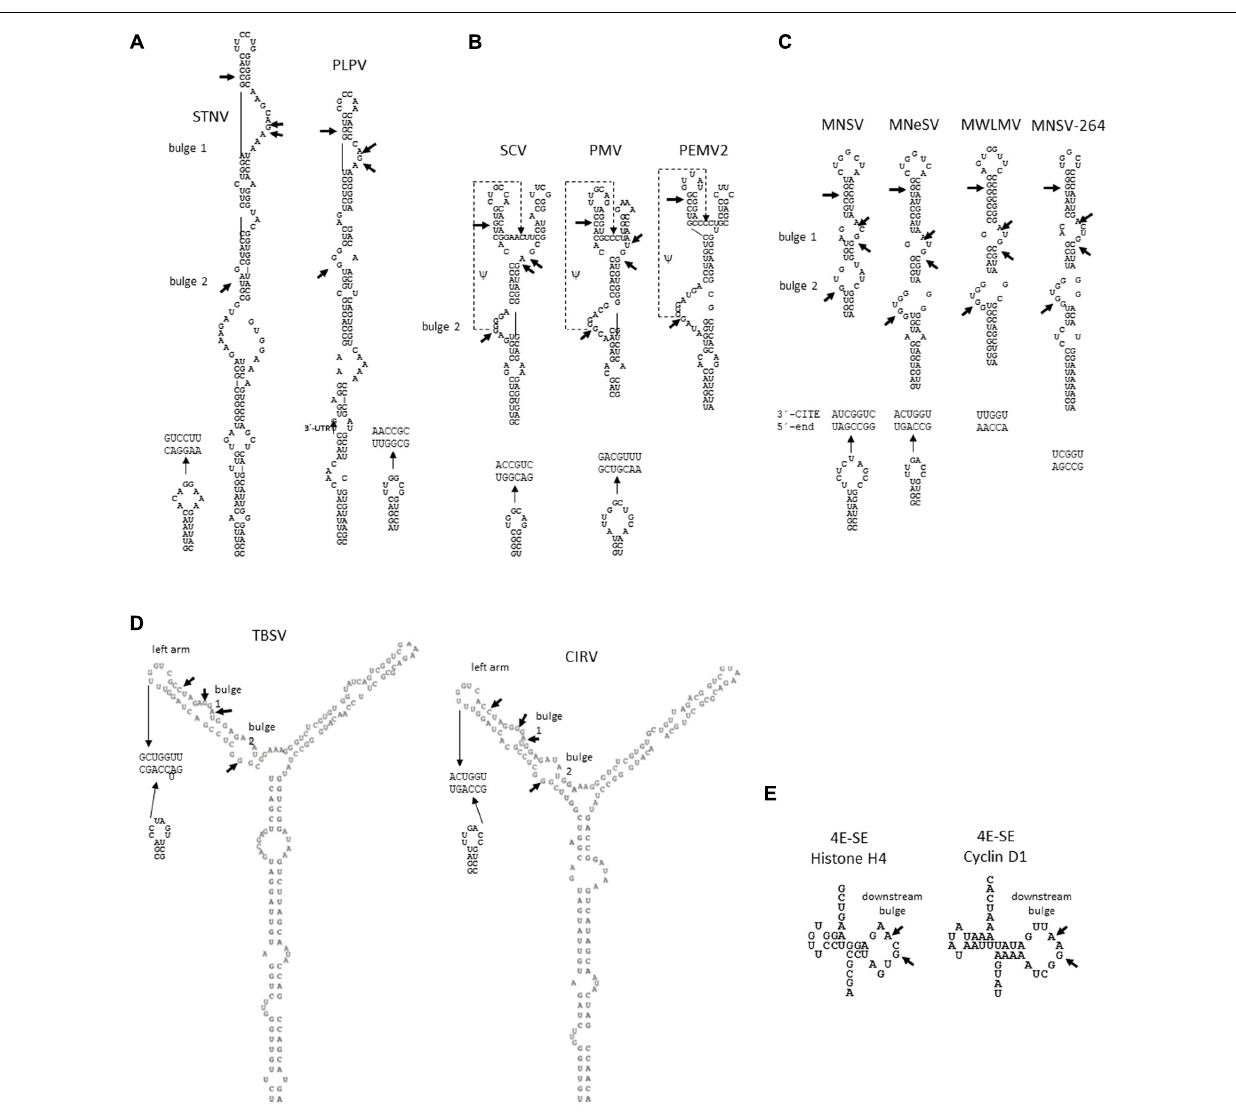
FIGURE 2 | RNA secondary structures of TED, PTE, ISS, and YSS, which are 3 (cid:48) -CITEs shown or proposed to interact with eIF4F through its eIF4E subunit. (A) Assayed (PLPV) and predicted (STNV) TED structures, based on data derived from Blanco-Pérez et al. (2016). (B) Assayed PTE structures of SCV, based on data derived from Chattopadhyay et al. (2011) and of PEMV and predicted PTE structure for PMV, based on data derived from Wang et al. (2009). The pseudoknot ( ψ ) between C- and G-domain is indicated with a dashed line. (C) Assayed (MNSV and MNeSV) and predicted (MWLMV and MNSV-264) ISS (Nicholson et al., 2010; Miras et al., 2017b). (D) Predicted YSS of TBSV, as proposed by Fabian and White (2006) and CIRV, as proposed by Nicholson et al. (2013). (E) Assayed structures of eIF4E sensitivity elements (4E-SE) of Histone H4, based on data derived from Martin et al. (2011) and Cyclin D mRNAs, based on data derived from Culjkovic et al. (2006). Dashes point to conserved residues shown or predicted to be involved in eIF4E binding. The sequences proposed or shown to be involved in 5 (cid:48) –3 (cid:48) - interaction through sequence complementarity are shown. In the case of MNeSV the 5 (cid:48) –3 (cid:48) -interaction was proved with the 5 (cid:48) -UTR of